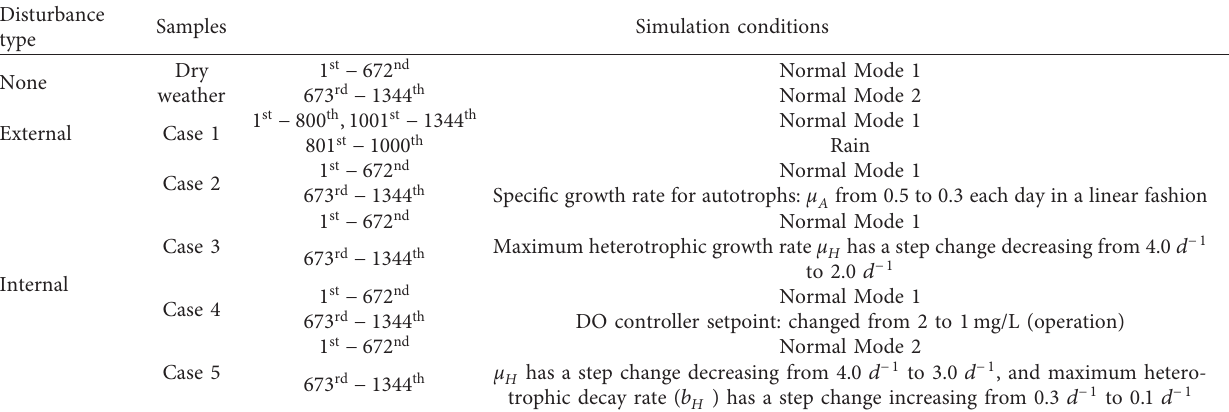
Table 7: Six simulation cases in the BSM1 benchmark.